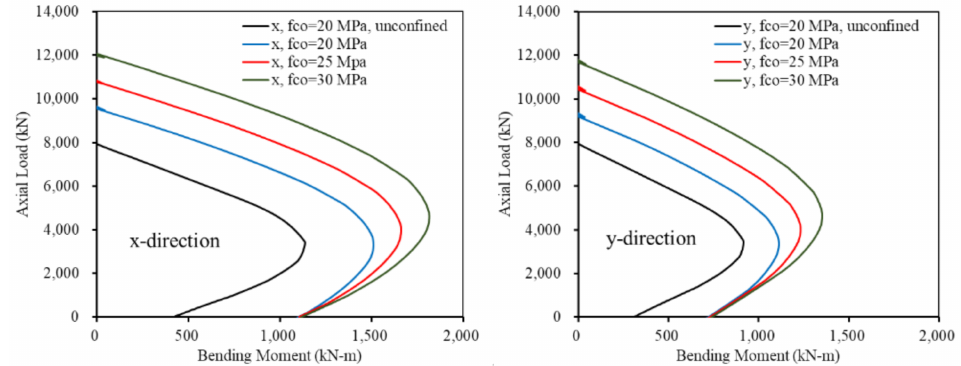
Figure 11. P-M interaction curves according to concrete strength (rectangular cross-section).